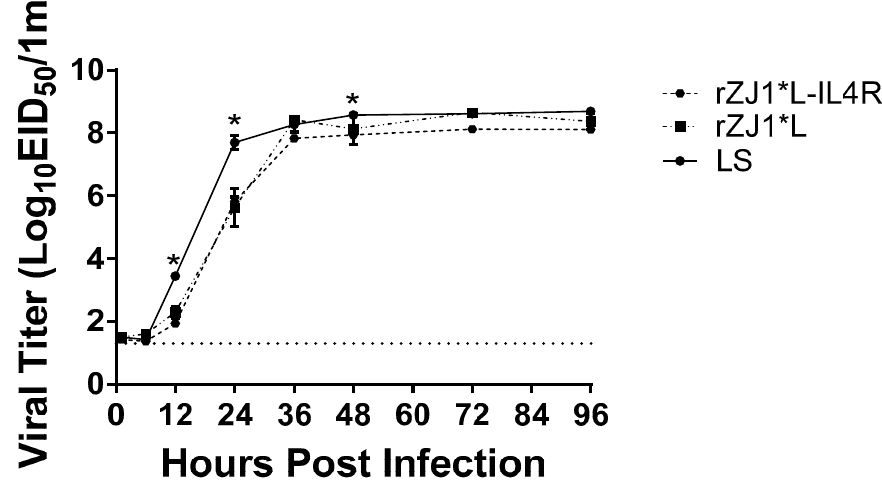
Figure 1. Growth kinetics of rZJ1*L, rZJ1*L-IL4R, and LS. Growth kinetics were determined by in- oculating 9-to-11-day-old SPF ECEs with 100 mL each, containing 10 2.5 EID 50 of the corresponding virus. Allantoic fluid was collected at 1, 6, 12, 24, 36, 48, 72, and 96 h post-infection and each time point was performed in triplicate. Viral titers were calculated using qRT-PCR. Differences were an- alyzed using a two-way ANOVA followed by a multiple comparisons Tukey’s test. Significant dif- ferences are denoted by * p ≤